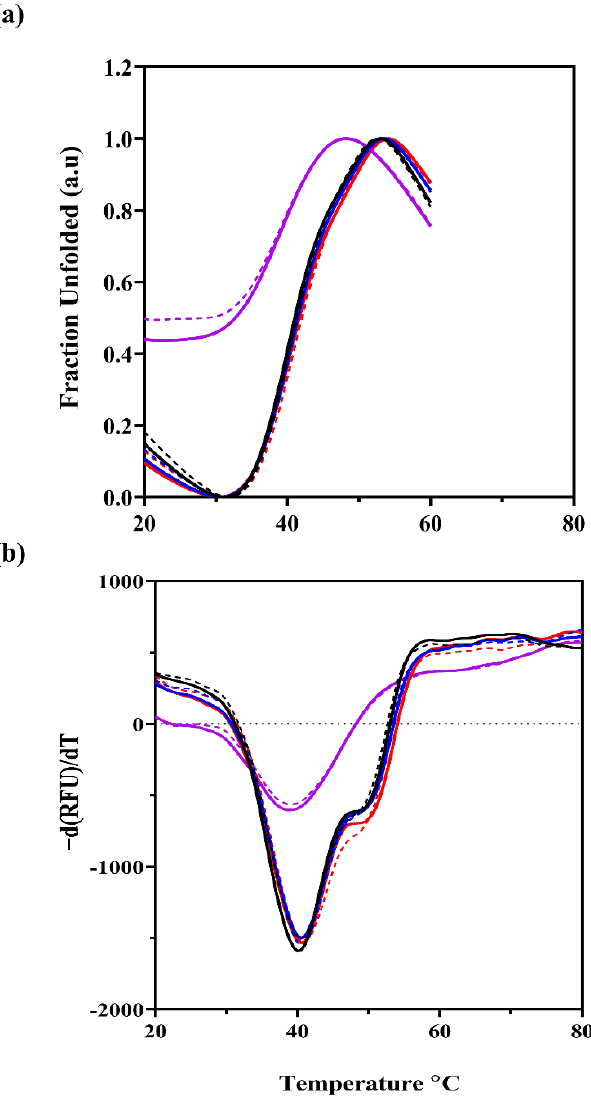
Figure 5. The fluorescence thermal shift analysis of recombinant KpNNAT ( a ) showing the thermal unfolding curves and ( b ) the melting curves of the protein in the absence of divalent cation (black line), and in the presence of Mg 2+ (blue line), Ca 2+ (red line), and Ni 2+ (purple line). The dotted lines indicate the absence of ATP, while the solid lines indicate the presence of ATP. Stability was monitored between 20 °C and 80 °C using SYPRO Orange dye in 25 mM Tris-HCl, pH 7.5 with 0.1 mM ATP and 5 mM salts (MgCl 2 , NiSO 4 , CaCl 2 , ZnSO 4 , and CuSO 4 ). The plot was generated using GraphPad Prism.